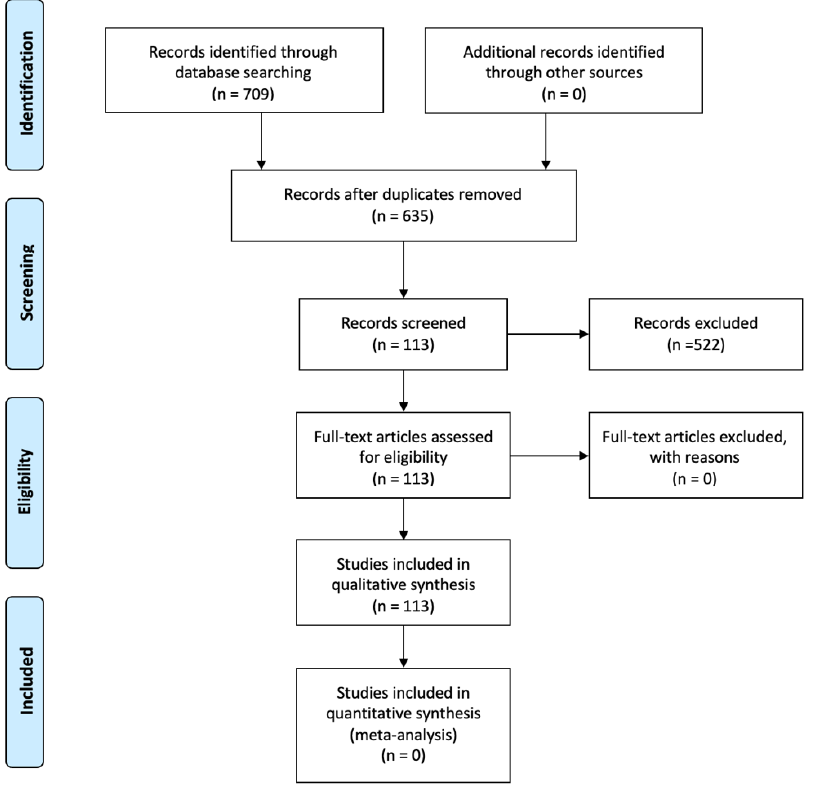
Figure 1. Prisma flow diagram of the systemic review process.